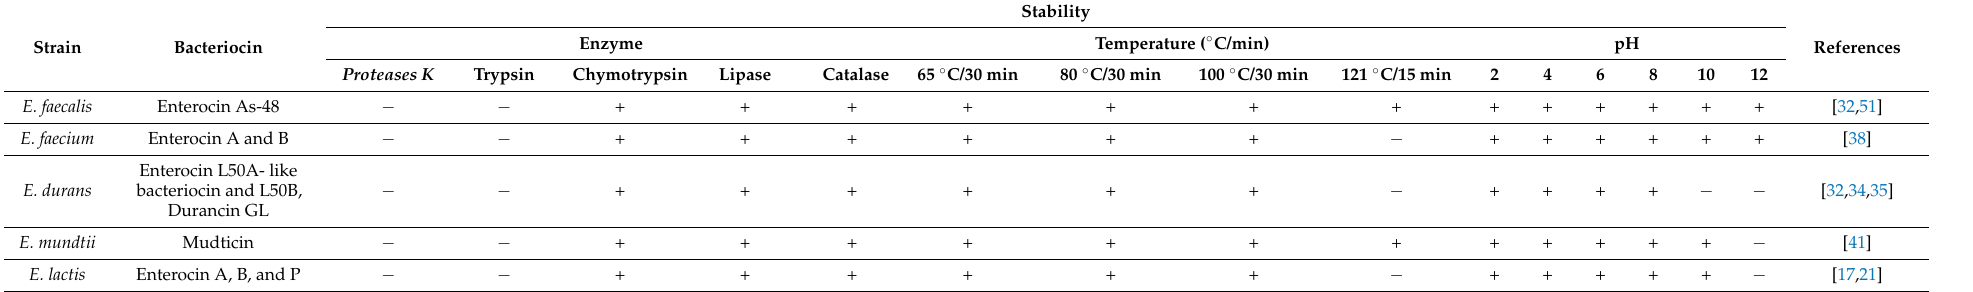
Table 4. Activity of bacteriocin produced by Enterococcus sp. against enzymes, temperature, and